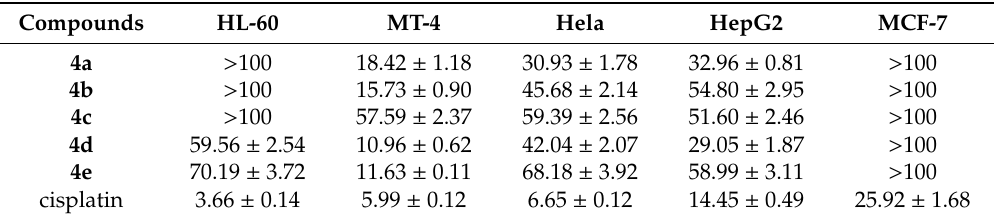
Table 3. The IC 50 value of the synthesized compounds obtained for anti-proliferative activity on different tumor cell lines ( μ M).